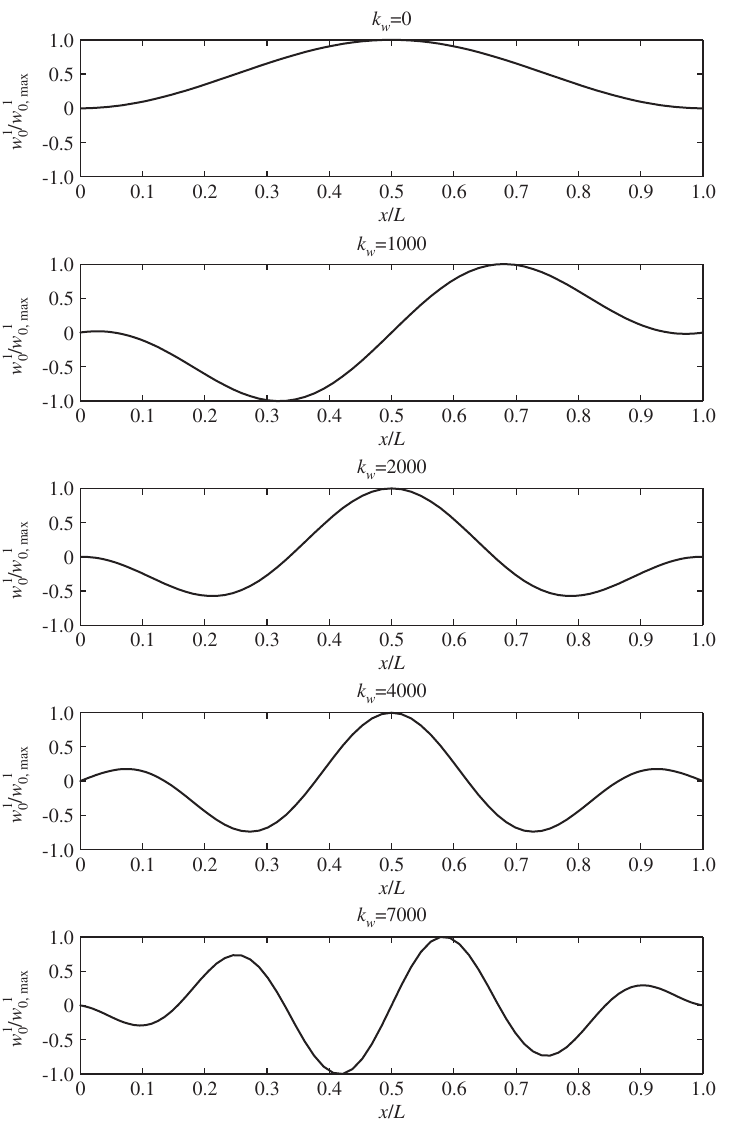
Figure 5 Buckled configurations of C-C composite laminated beams with L / h = 20 and [0/90/0] lay-up resting of Winkler